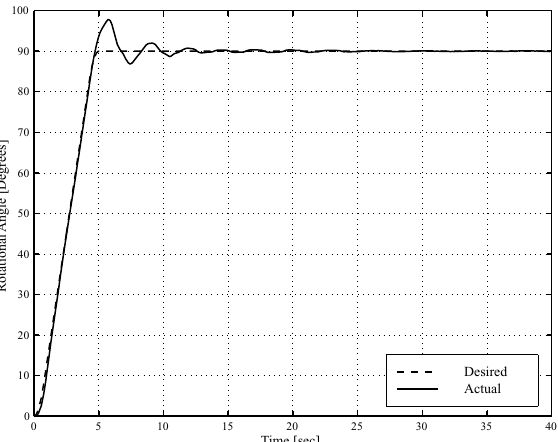
Fig. 24. Desired and actual rotational angles for the compound case using the fuzzy